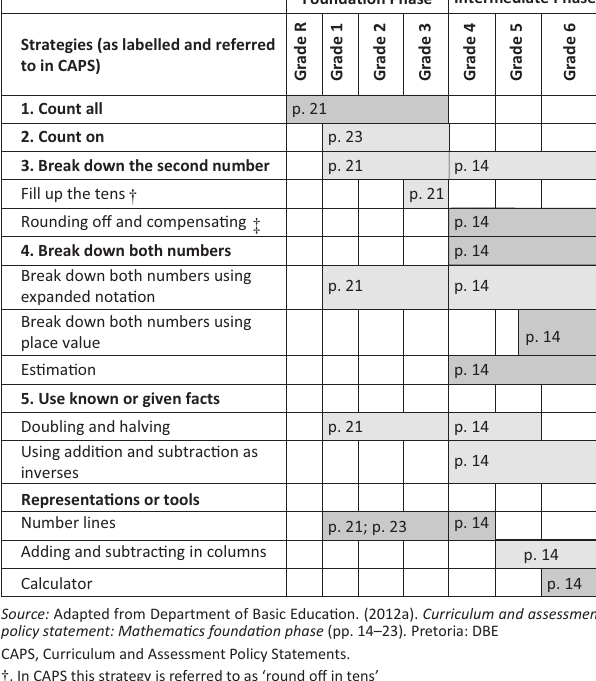
FIGURE 8: Grade progression for addition calculation strategies in